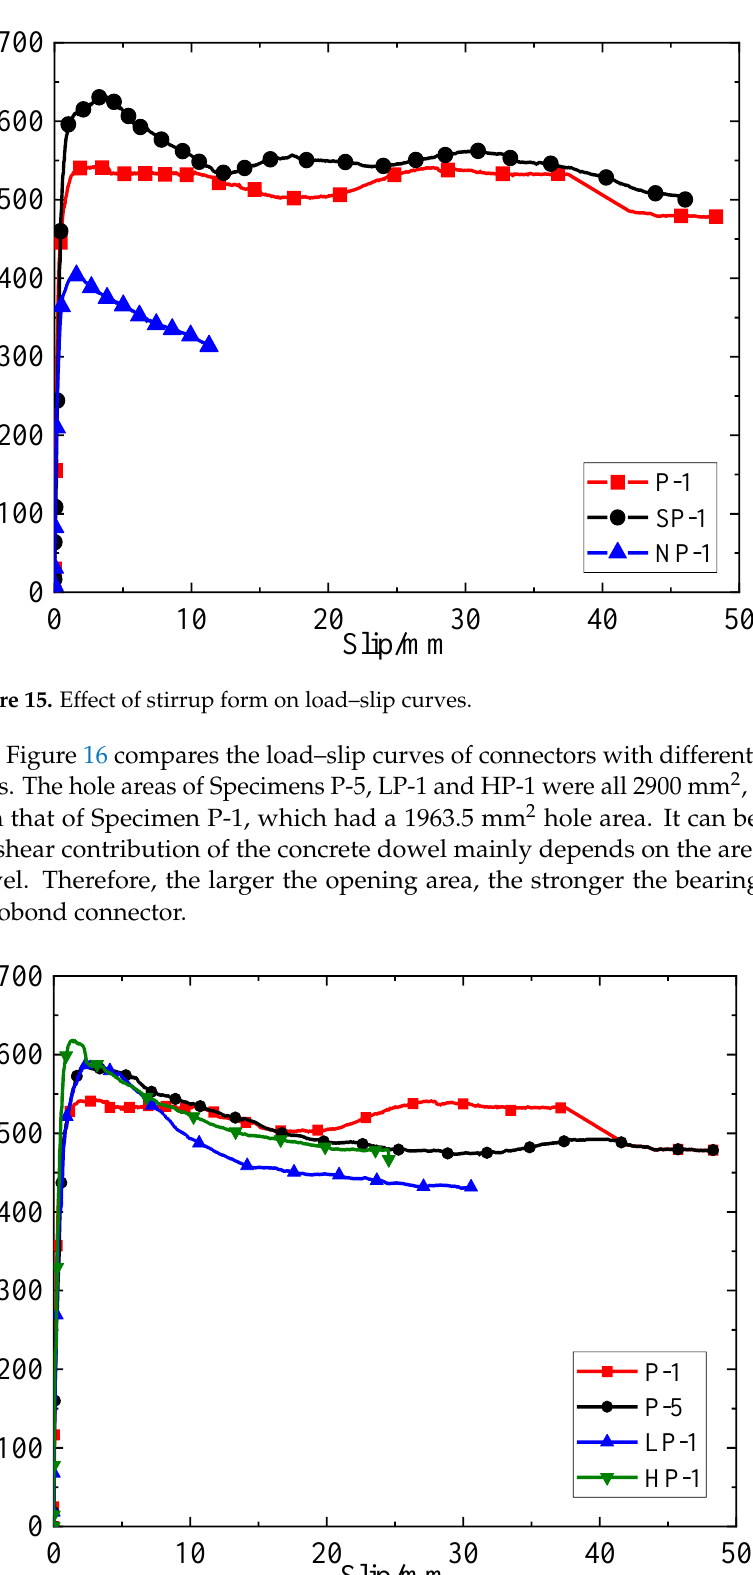
Figure 16. Effect of hole shape and size on load–slip curves.